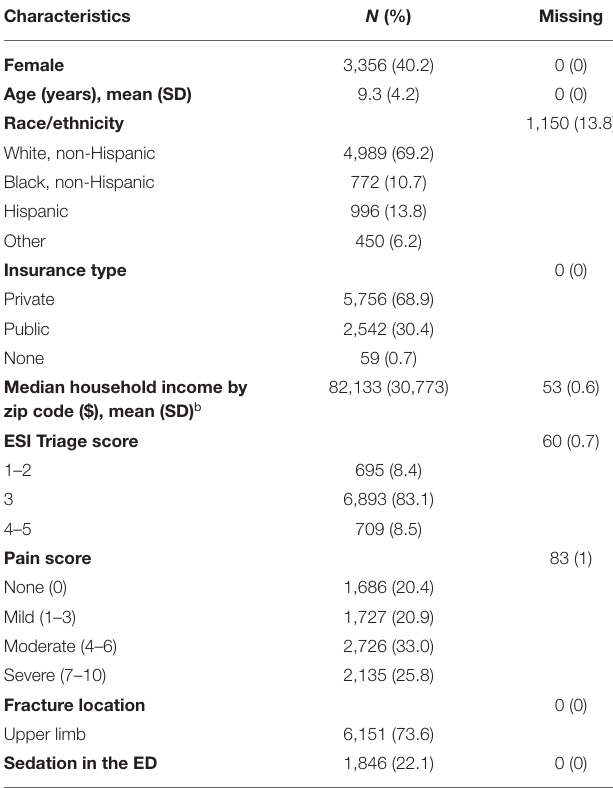
TABLE 1 | Visit characteristics of children with limb fracture ( N = 8,357) a